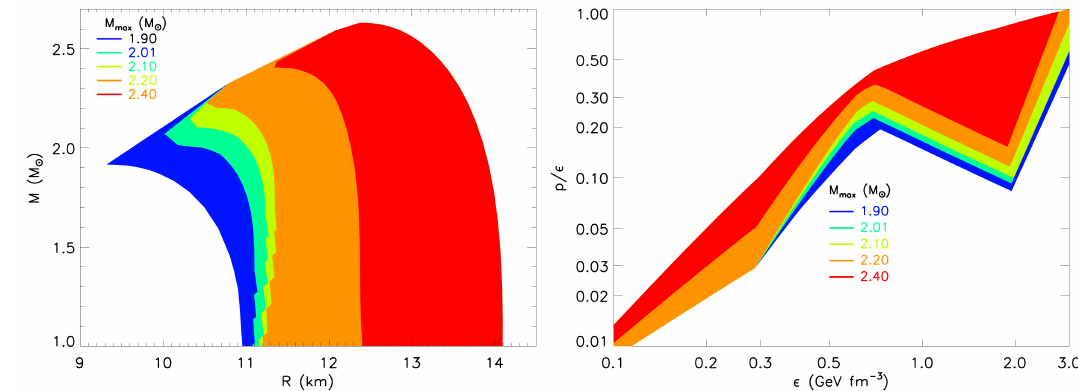
Figure 4. Left : Allowed regions of M − R space. Right : Allowed regions of p / ε − ε space. Colors denote the results of varying the assumed minimum value of M max